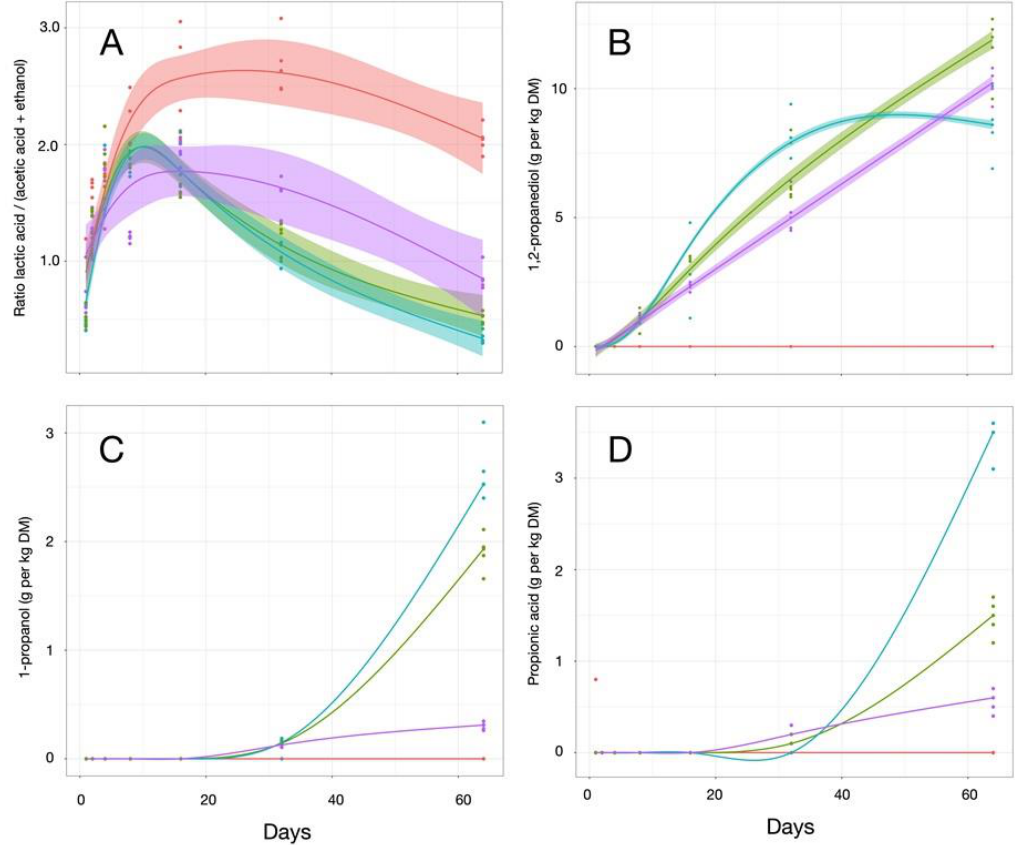
Figure 7. Ratio of the concentration of lactic acid/(acetic acid + ethanol) ( A ) and propionate metabolic pathway compounds (1,2-propanediol ( B ), 1-propanol ( C ), propionic acid ( D )) from independent samples of corn silage harvested after 1, 2, 4, 8, 16, 32, and 64 days of fermentation. The following four inoculation treatments were applied: Control, Lb. buchneri , Lb. hilgardii , and a combination of the two LAB species. The trend lines correspond to a smoothing function computed by linear modelling using the y~ns(x,3) equation. The shaded area boarding each trend line represents the 95% confidence interval.